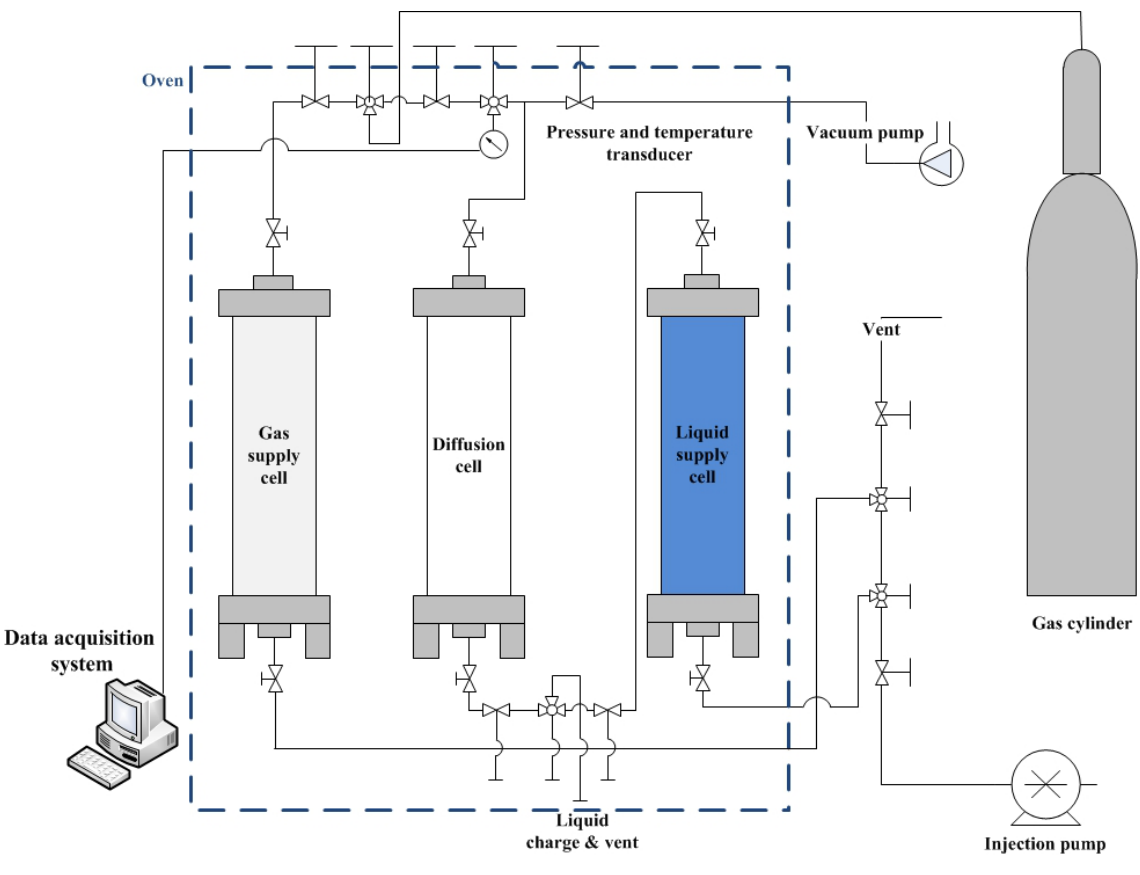
Figure 2. Schematic of experimental set-up.